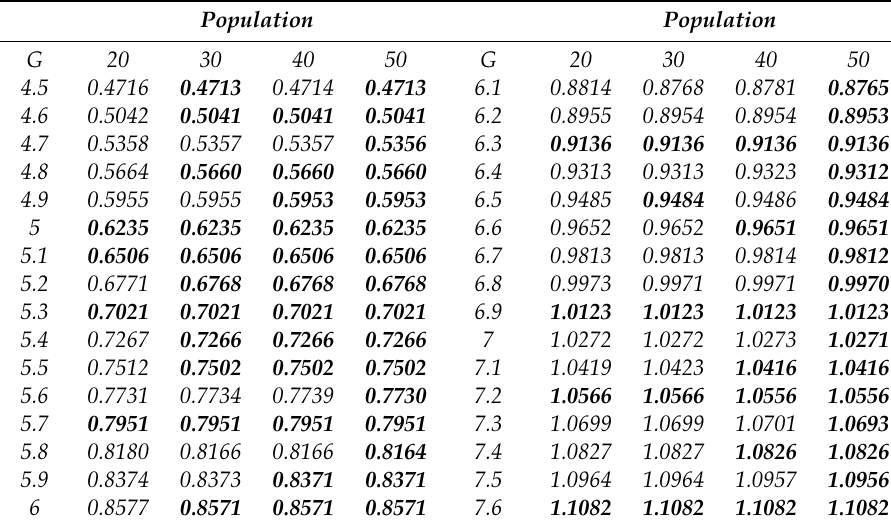
Table 1. Comparative table of the obtained results using di ff erent population sizes.